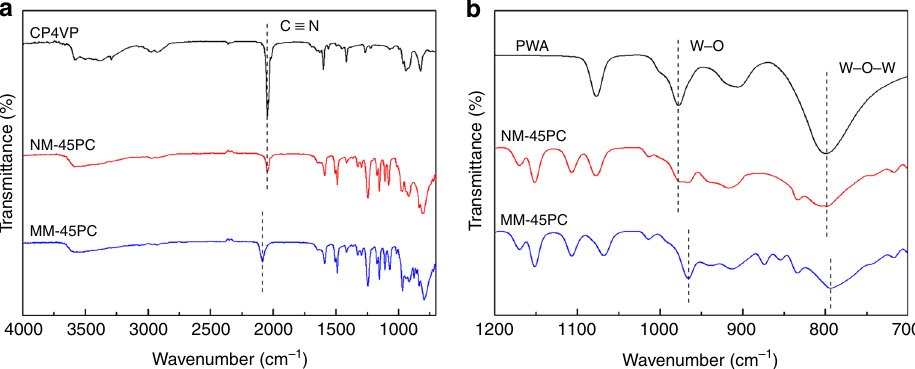
Fig. 5 Comparative infrared spectra. ATR-FTIR spectra of MM-45PC relative to membrane composition and NM-45PC are shown. a MM-45PC shows red shift for the cyano group absorption band, indicating an enhanced vibration of C ≡ N bond due to the loss of the electron on nitrogen. b MM-45PC shows blue shifts for W – O and W – O – W vibrations, re fl ecting attenuated vibrations of W – O and W – O – W bonds caused by the transfer of electrons from nitrogen to tungsten. In combination, these shifts in absorption bands demonstrate that under magnetic fi eld in fl uence, electron transfer and an interaction occur between CP4VP and PWA in MM-45PC (dashed lines are used to guide the eyes). ATR-FTIR: attenuated total re fl ection fl ourier transformed infrared spectroscopy; CP4VP: ferrocyanide-coordinated poly(4-vinylpyridine); PWA: phosphotungstic acid; NM-45PC: normal-cast membrane with 45 wt% loading of proton-conducting components; MM-45PC: magnetic-cast membrane with 45 wt% loading of proton-conducting components. Source data are provided as a Source Data fi